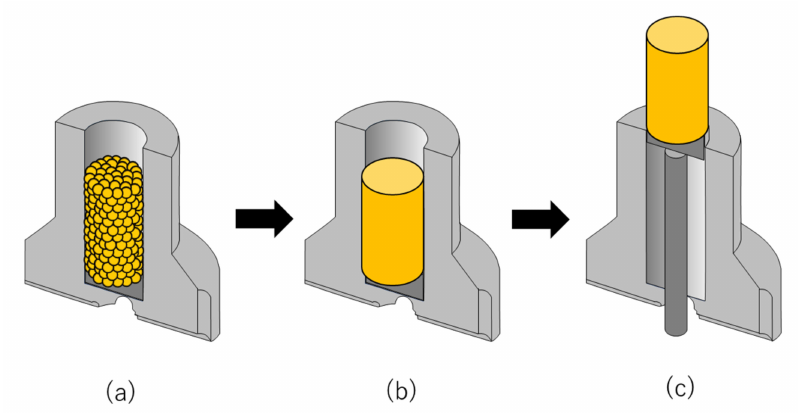
Figure 1. The fabrication of sca ff old-free adipose tissue-derived mesenchymal stem cell (AT-MSC) construct using the “mold”. ( a ) Spheroids are piled up into a “mold” and employed to fabricate sca ff old-free columnar cell constructs. ( b ) Spheroids are cultured and matured in the “mold” to fuse. ( c ) The sca ff old-free cell construct is retrieved from the “mold” and used for implantation and analysis. In this figure, half of the mold is illustrated for the convenience of